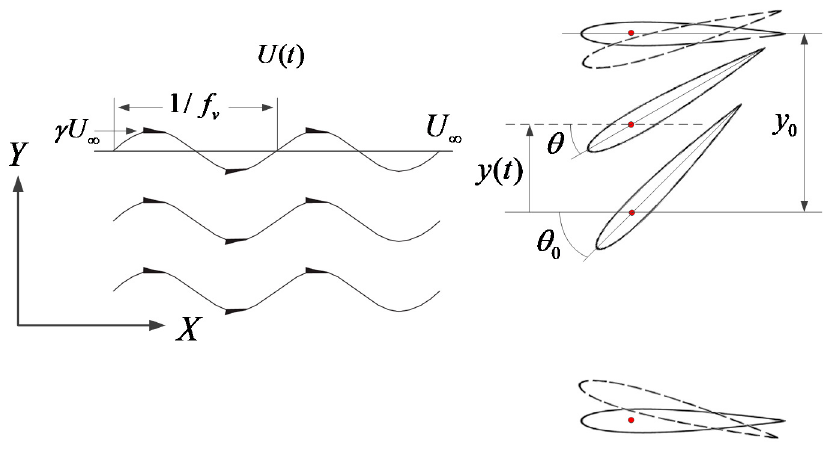
Figure 1. Sketch of full-active flapping foil under time-varying freestream velocity.